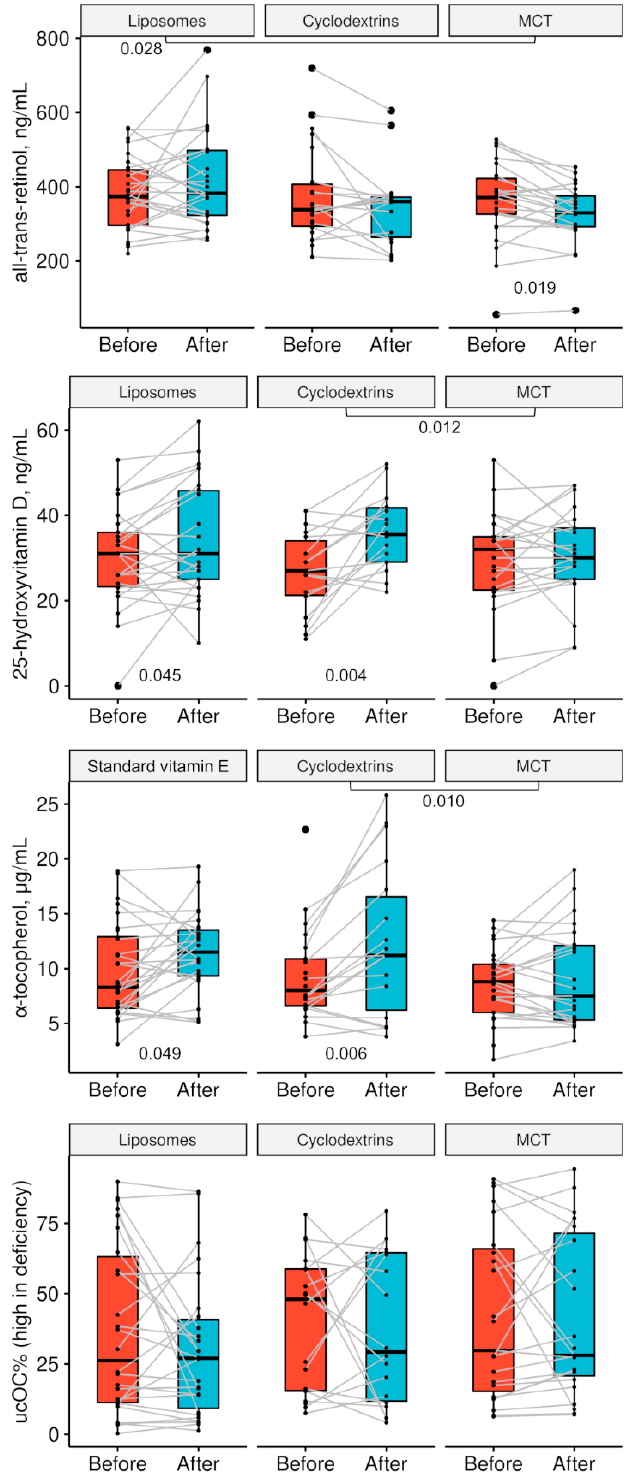
Figure 2. Concentrations of all-trans-retinol, 25-hydroxyvitamin D, and α -tocopherol, as well as the percentage of undercarboxylated osteocalcin (ucOC%) in PI patients with CF before and after 90 days of fat-soluble vitamin supplementation in the liposomal or cyclodextrin form and in the MCT control group. Significance of before–after differences between the groups is shown beneath group labels (Mann–Whitney U test); p values for comparison of vitamin levels before and after the intervention within individual groups are shown below boxplots. Boxplots illustrate the quartiles. Please note that patients in the liposome group received a standard vitamin E supplement.